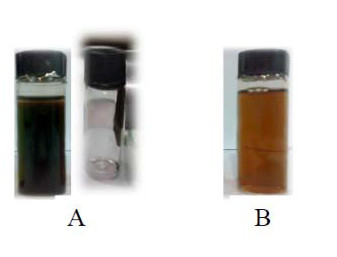
Separation of Fe3O4 nanoparticles by magnetic effect (A), Fe3O4-gold core-shell solution (B).